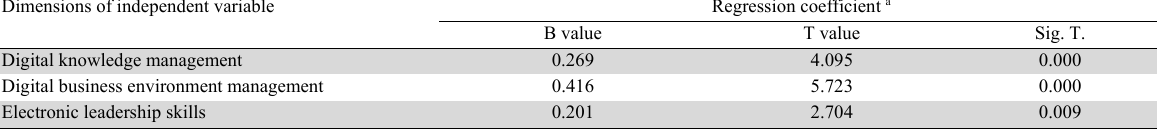
The results of the multiple regression analysis to test the main hypothesis Dimensions of independent variable